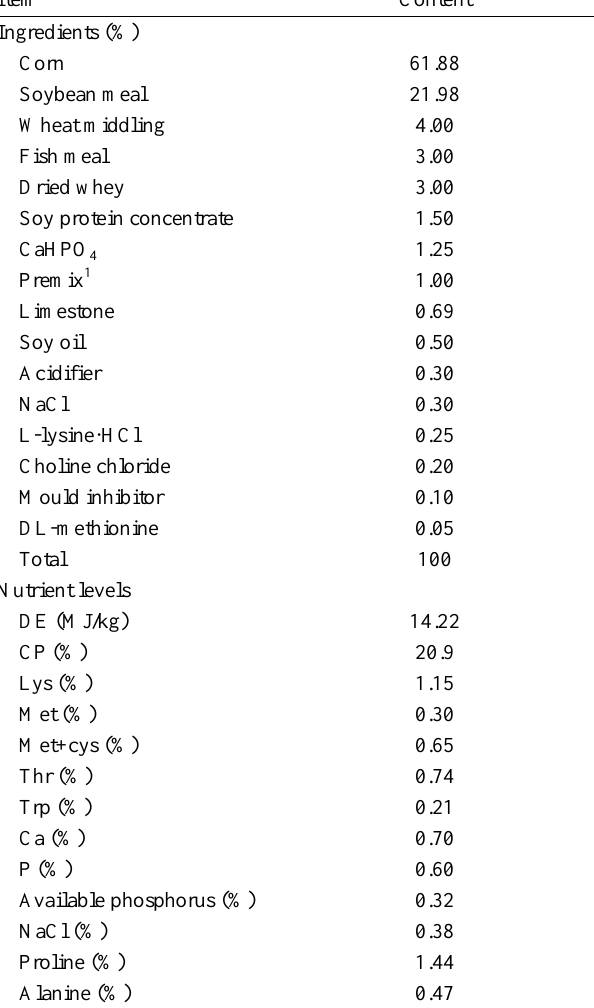
Table 1. The composition and nutrient contents of basal diet (air dry